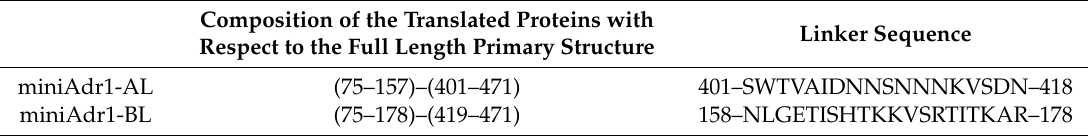
Table 3. Primary structure of the linkers between TAD I and TAD III in the miniAdr1 constructs.